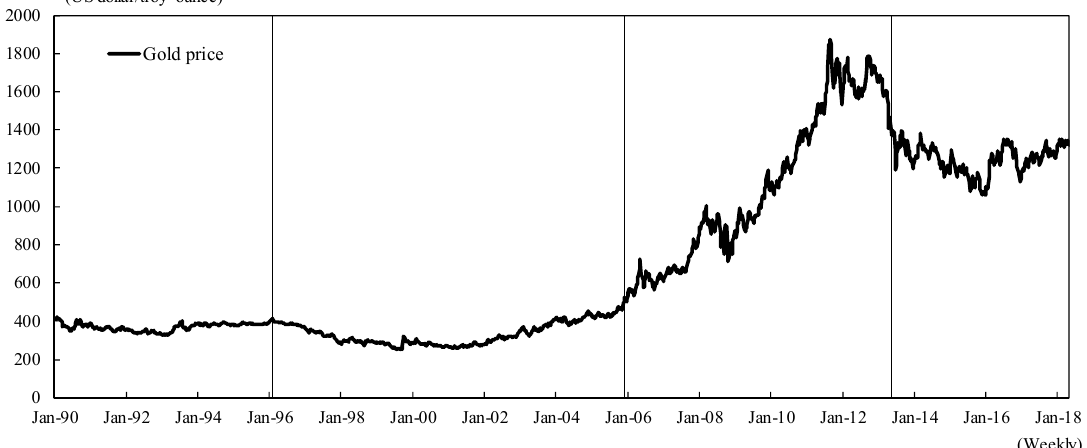
Figure 2. The solid vertical lines in the figure represent the break dates specified by applying Bai and Perron’s (1998, 2003a, 2003b) method.